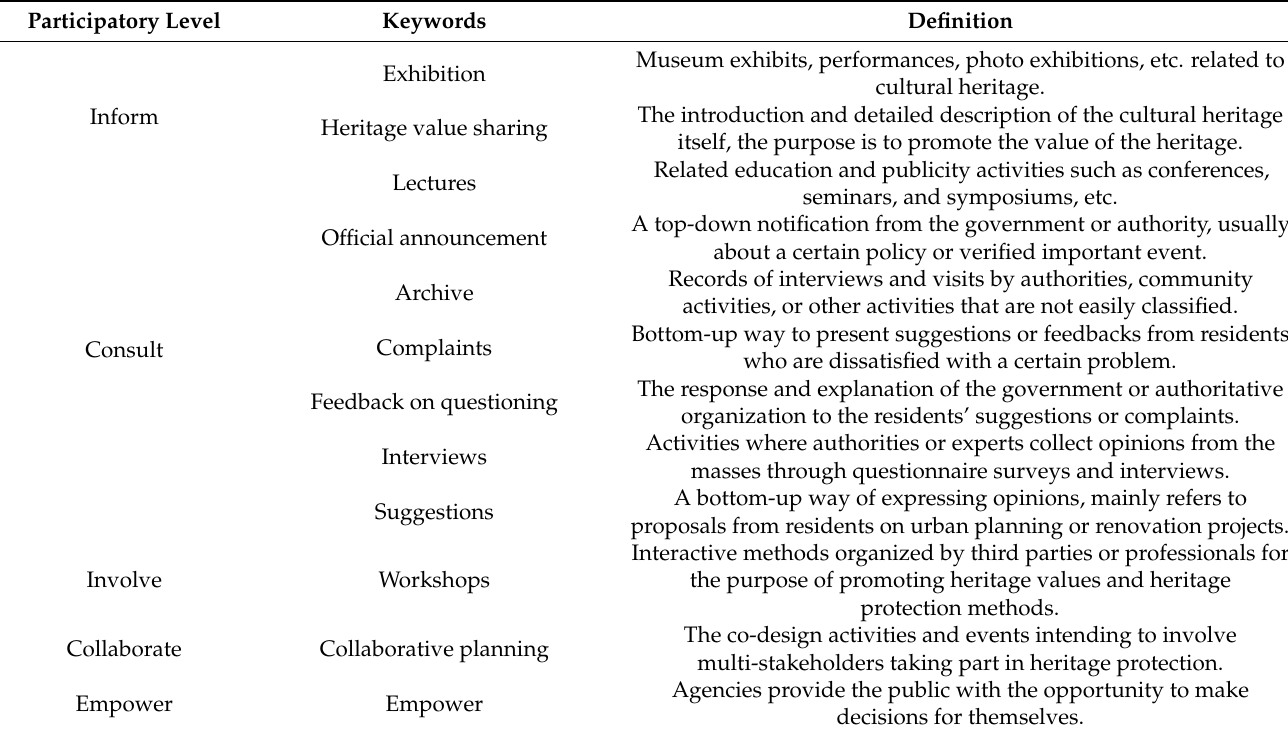
Table 3. The identification and labelling framework for content